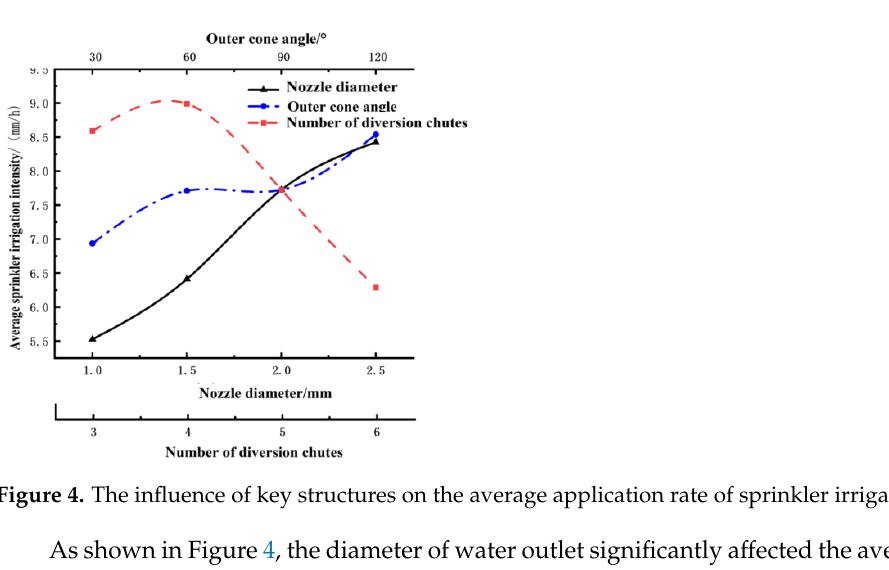
6 of 16 Table 3. The influence of key structures on the irrigation flow rate and wetted radius. Structural Parameters